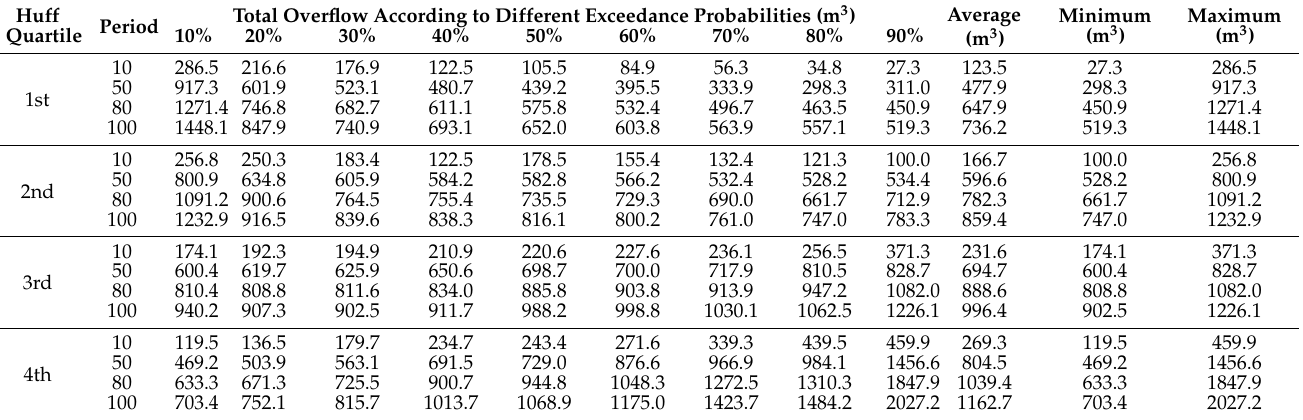
Table 4. The EPA-SWMM-model-simulated total overflow results for a 3-h duration. Huff Quartile